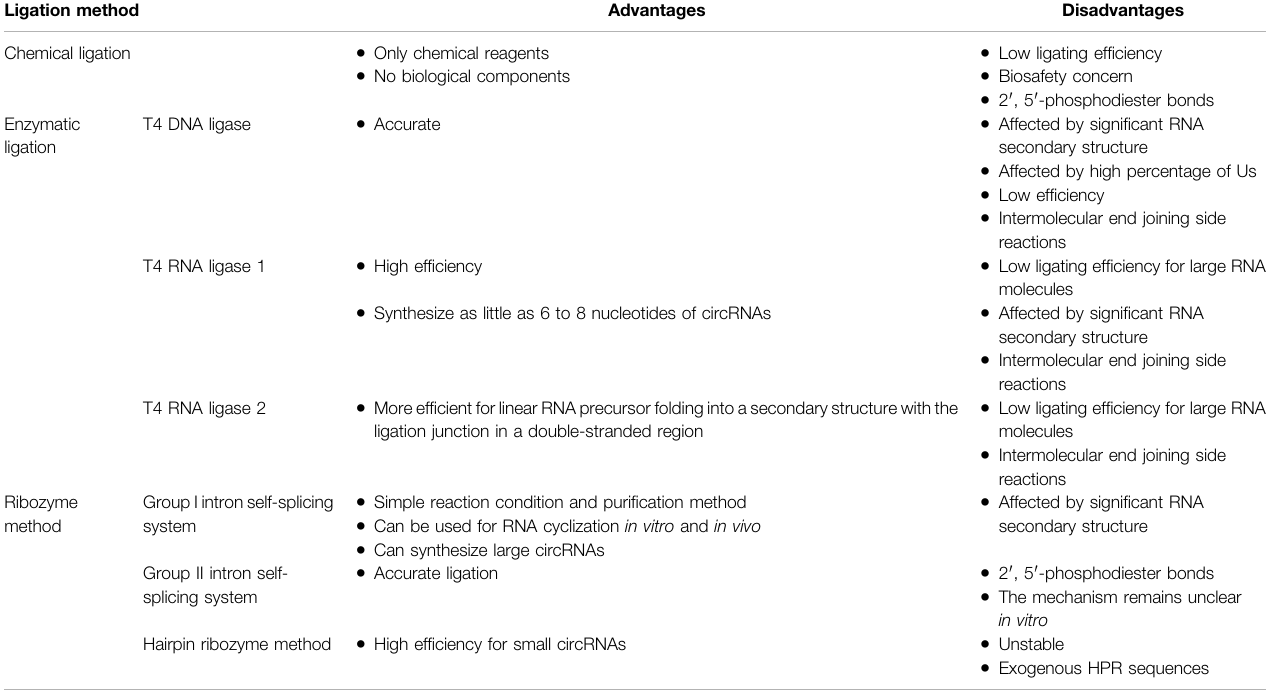
TABLE 1 | Advantages and disadvantages of different ligation